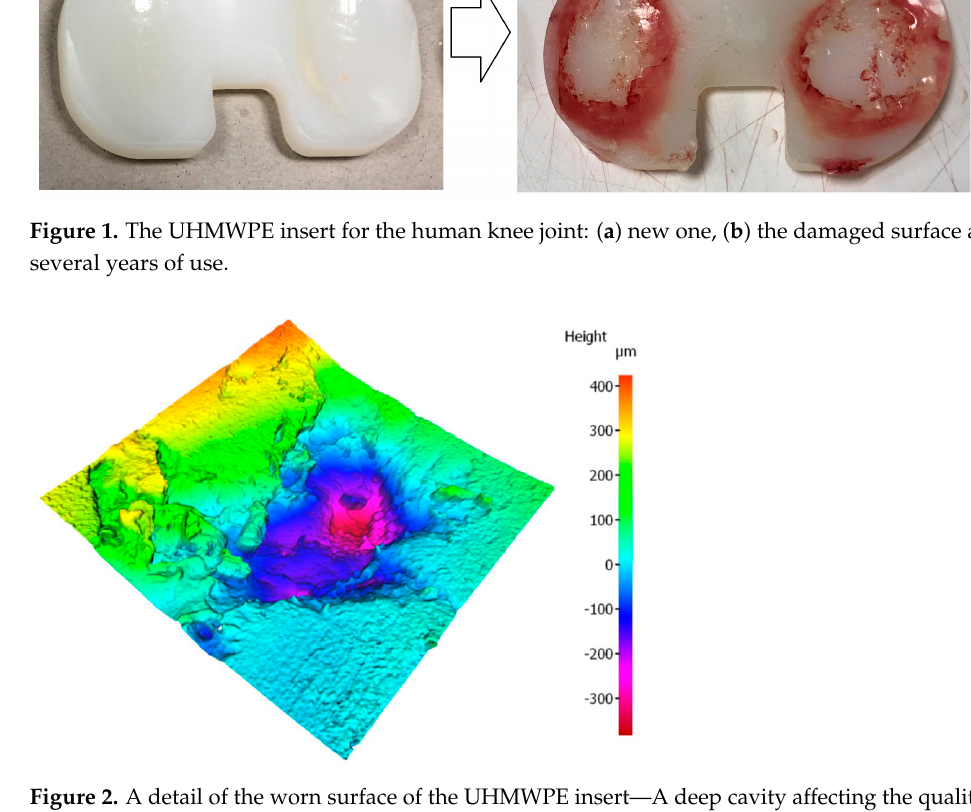
Figure 2. A detail of the worn surface of the UHMWPE insert—A deep cavity affecting the quality of the tribological contact.